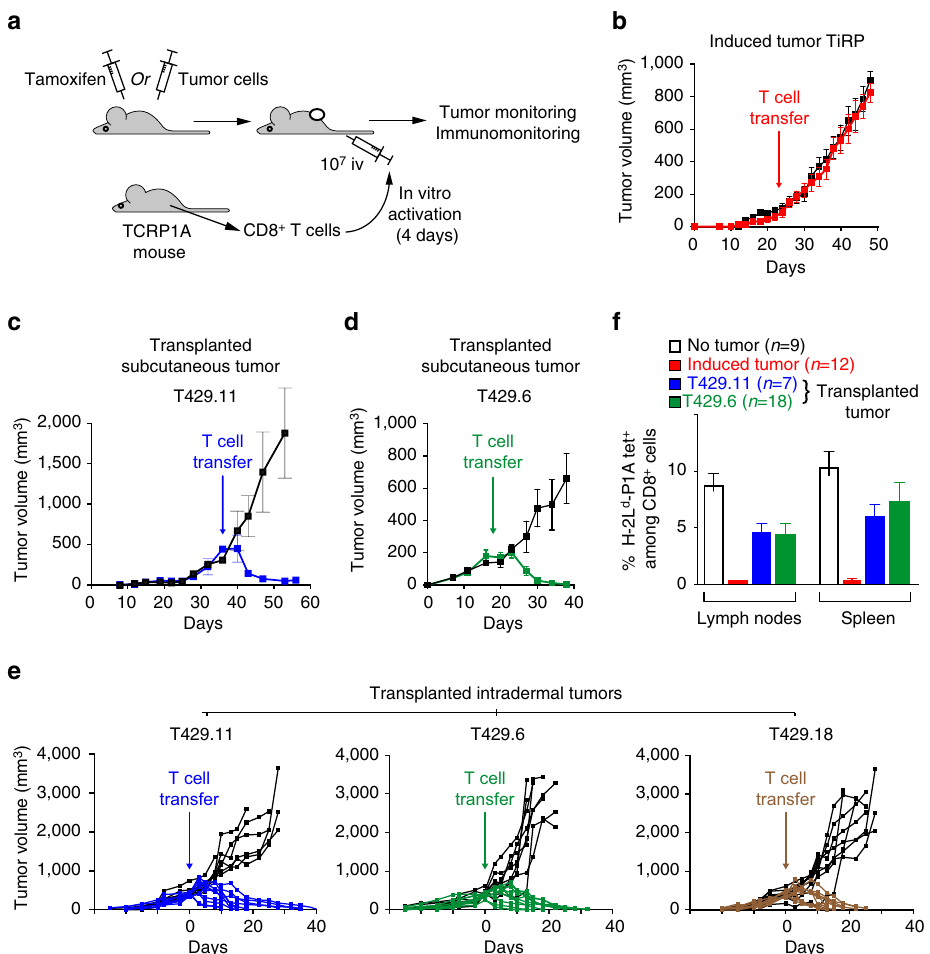
Fig. 2 Rejection of transplanted but not induced autochthonous tumors after adoptive transfer of tumor-speci fi c CD8 + T cells. a Adoptive transfer